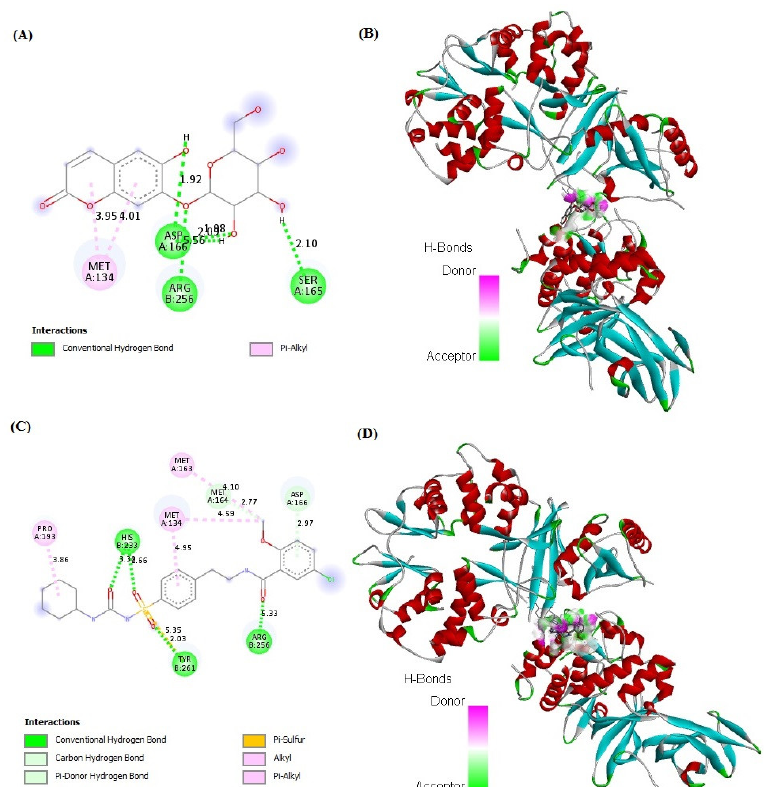
Figure 4. In silico analysis showing docking, amino acid binding interactions and binding pocket of ligand–receptor interactions of cichoriin ( A , B ) and GB ( C , D ) with GLUT4. Glibenclamide (GB); glucose transporter type 4 (GLUT4).